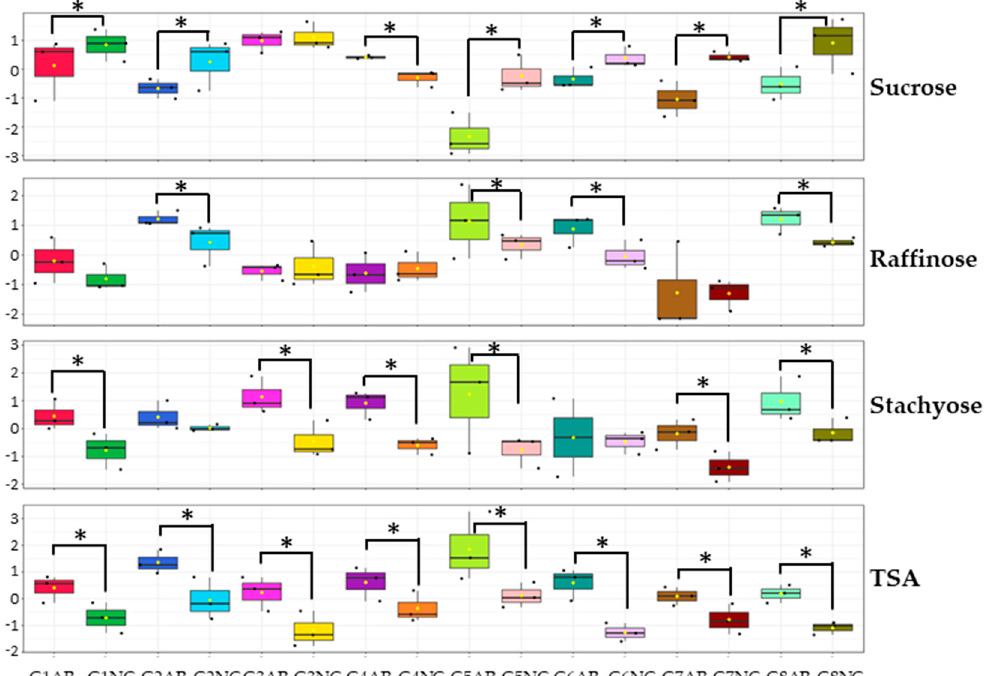
Figure 4. Main soluble sugar and total sugar alcohol content in the eight soybean genotypes (G1 to G8) cultivated in two different locations (Arkansas, AR, and North Carolina, NC). The content levels